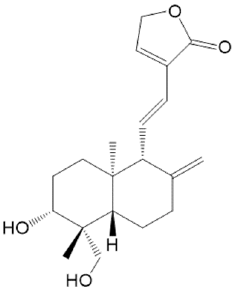
Figure 1. Chemical structure of 14-Deoxy-11,12-didehydroandrographolide (deAND).